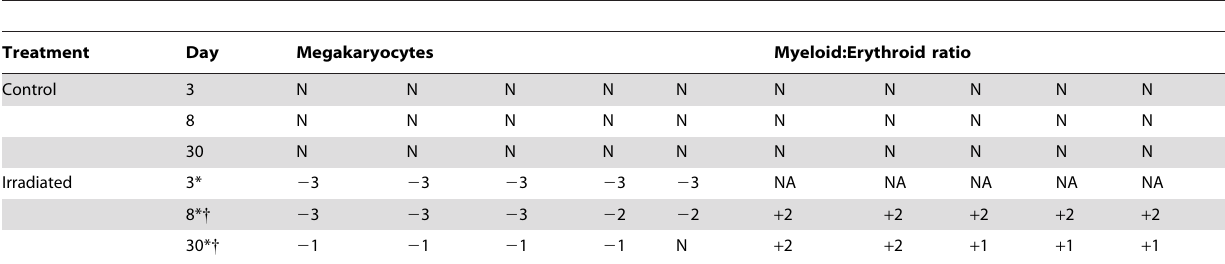
Table 1. Megakaryocyte number and myeloid: erythroid ratio in intact control (I 2 R) and irradiated (I + R) mice estimated by a board certified veterinary clinical pathologist (LS) according to standard protocols.